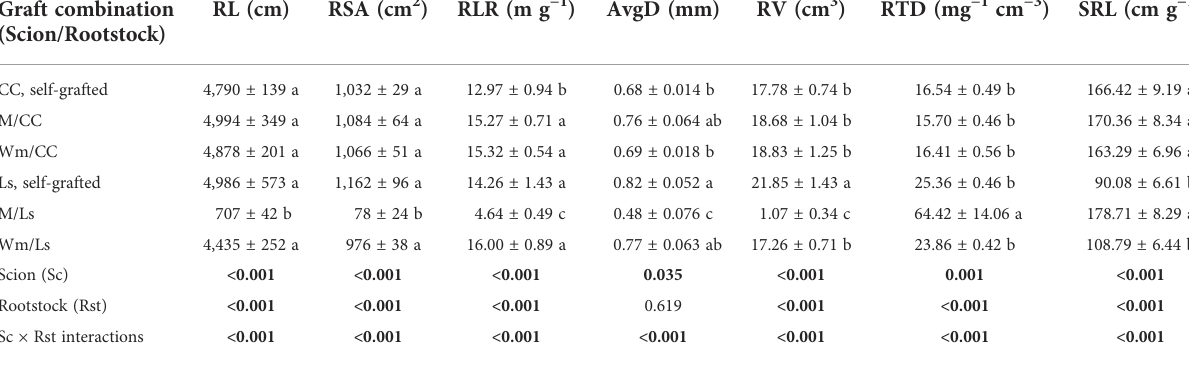
Different letters indicate signi fi cant differences within parameters (Tukey test, p < 0.05; mean ± SE); signi fi cant p-values of a two-way ANOVA are indicated in bold.